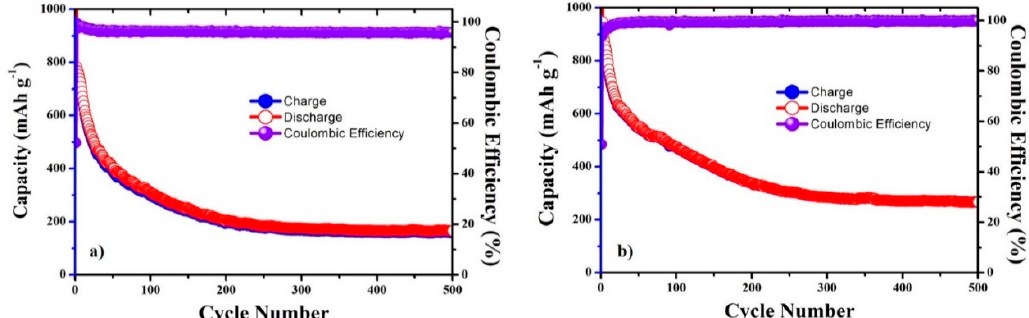
Figure 4. Cyclic performances of the ( a ) CNC–SnO 2 NF500 and ( b ) CNC–SnO 2 NF800 composite electrodes at 100 mA g − 1 .